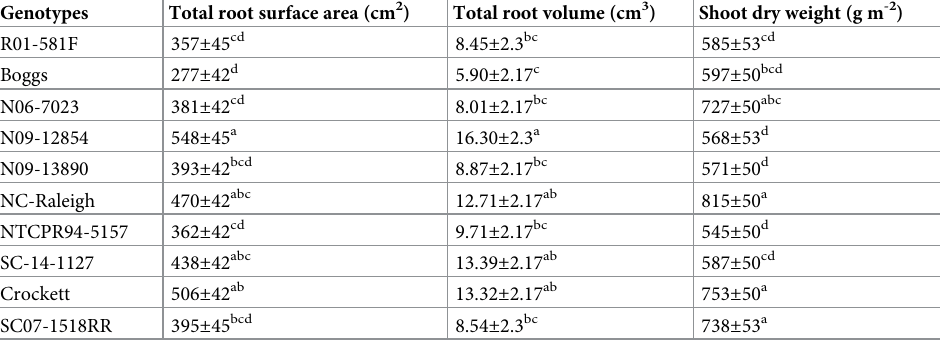
Values shown are least square means ± standard errors. Least square means with different letters are significantly different according to the LSD test at P <